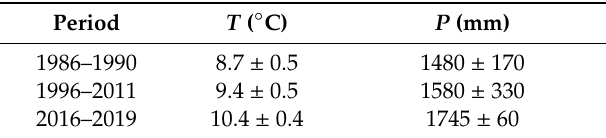
Figure 3. ( a ) Monthly mean temperatures at the Plitvice Lakes meteorological station in the three periods when data are available; ( b ) mean annual temperatures at the Plitvice Lakes in 1986–2019 (only years with complete data for 12 months are shown). Table 2. Mean annual temperature and annual precipitation amount in the three periods with available meteorological